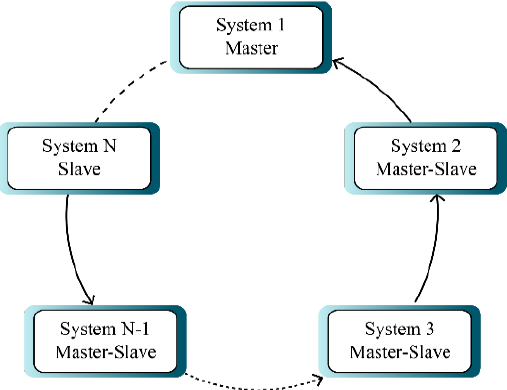
Figure 2. Structure of circular synchronization.